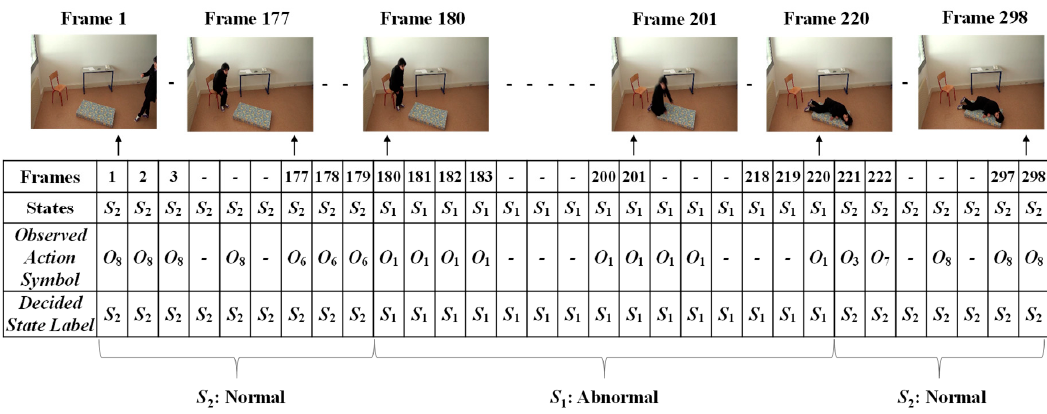
Figure 18. Results for deciding on the sequential abnormal and normal states for Ms. TWO (Video 3).